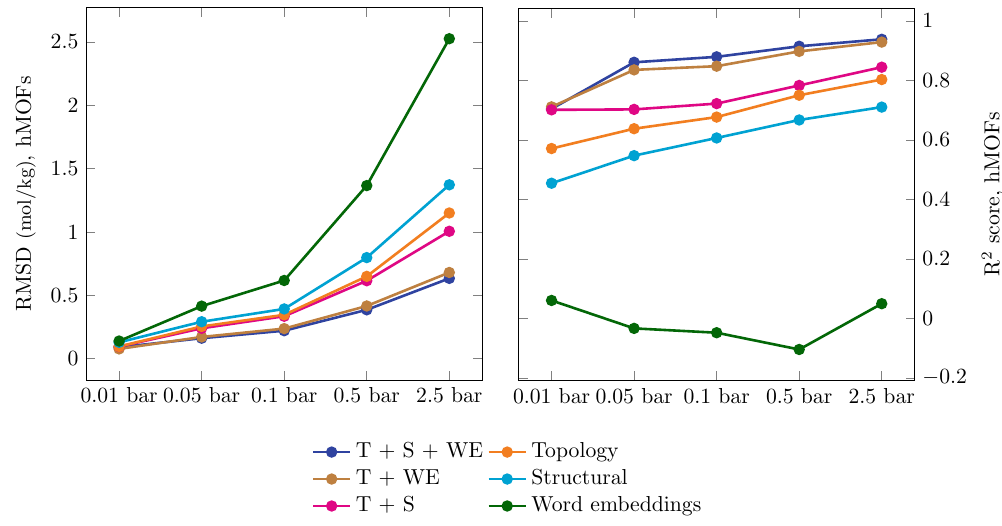
Figure 2. Model performances for hMOF dataset and CO 2 adsorption. Comparison of root-mean-square deviation (left), coefficient of determination (right) in predicting gas uptakes in CO 2 for different features at different pressures for the hMOF dataset. The RMSD is low at lower pressures because the distribution of carbon dioxide adsorption capacity has low variance in this regime. The topological features consistently outperform the standard structural features at all pressures. The T + WE and T + S + WE models achieve the best performance in